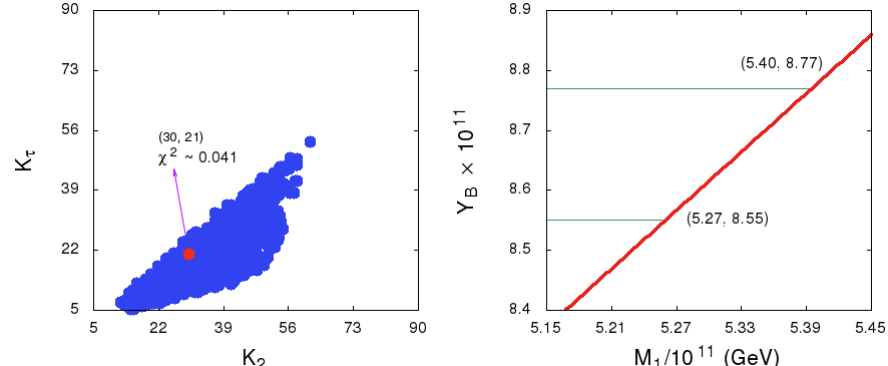
Figure 11 . The plot on the left hand side shows the range of the wash-out parameters. The red dot corresponds to the minimum value of (cid:31) 2 for which a set of primed parameter has been taken to compute Y B . The plot on the right hand side shows (cid:12)nal Y B for di(cid:11)erent values of M 1 for the inverted light neutrino mass ordering.